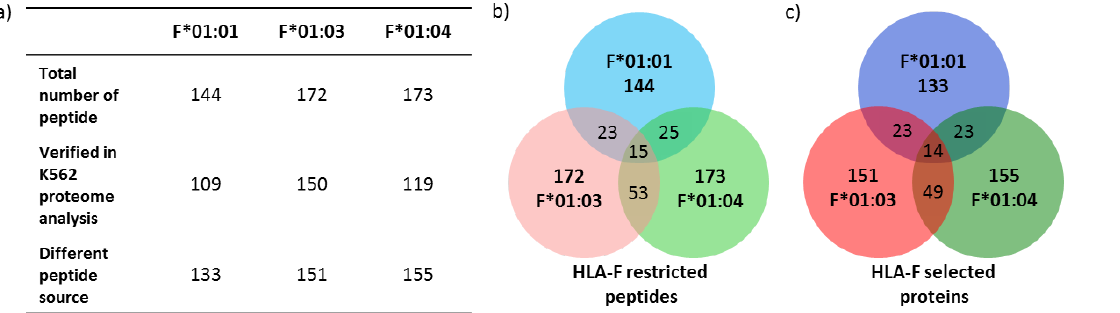
Figure 2. Features of HLA-F restricted peptides. ( a ) Overview of total number of HLA-F restricted peptides and the amount of different peptide source. ( b ) Venn diagram of HLA-F restricted peptides of three allelic variants. ( c ) Venn diagram of HLA-F selected proteins of HLA-F*01:01, HLA-F*01:03 and HLA-F*01:04.